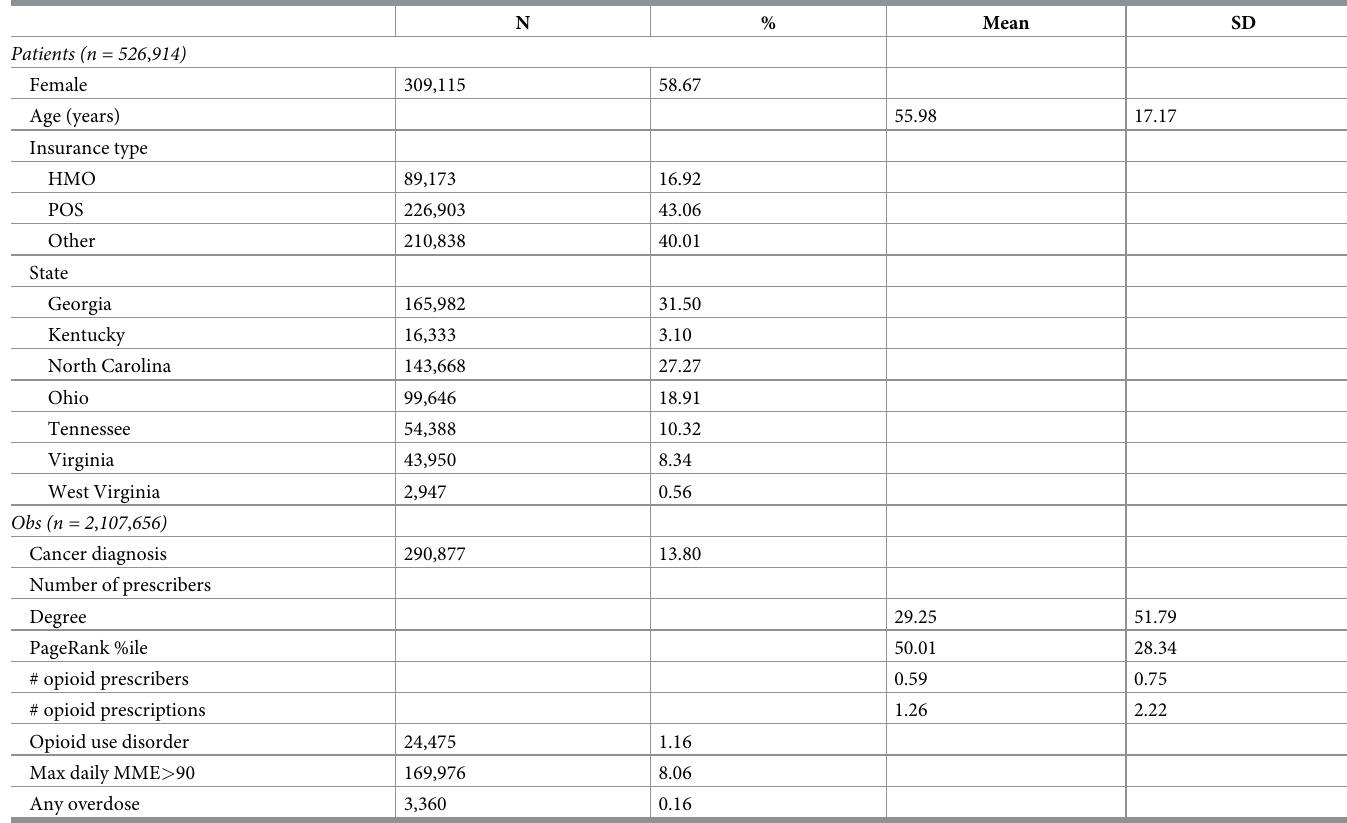
Table 1. Sample descriptive